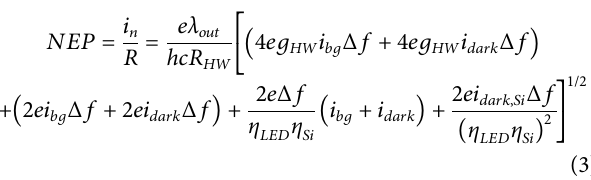
Frontiers in Physics |